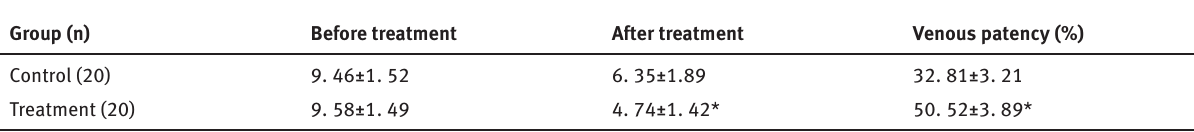
Table 3: Venous patency scores before and after treatment in the patient groups